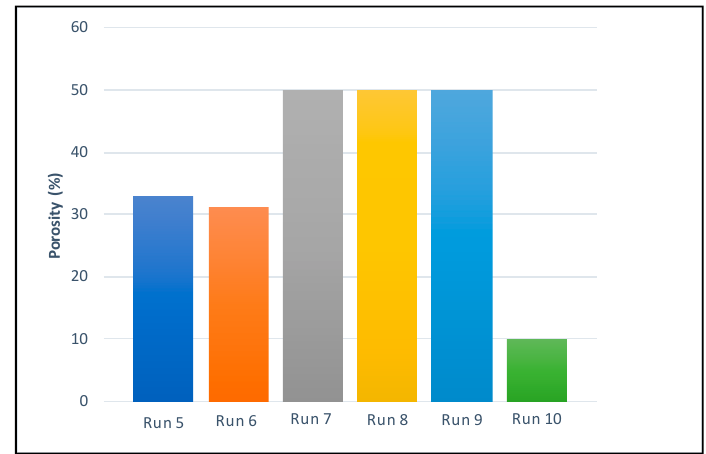
Figure 5. Porosity percentages of the final scaffolds. Table 2. Summary of data corresponding to runs and their resulting scaffolds. Run